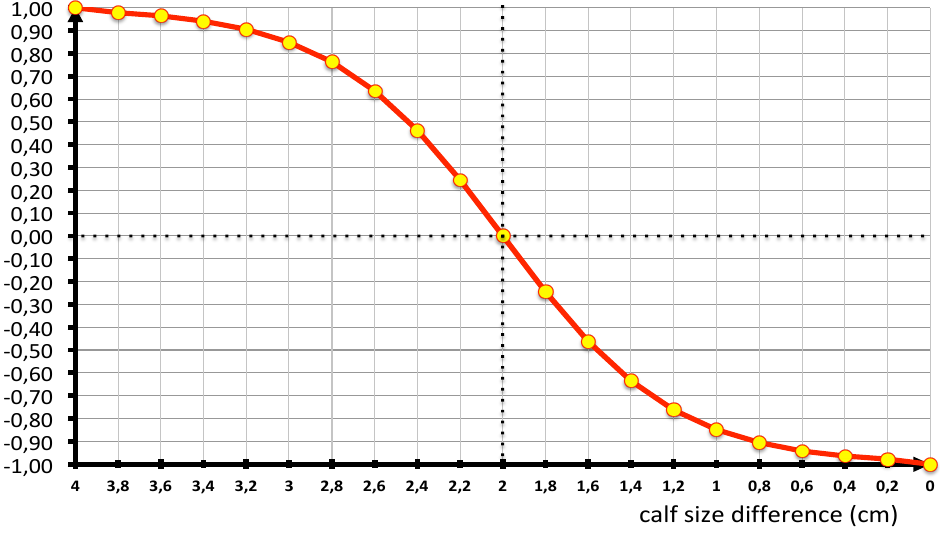
Figure 21. Fuzzy characteristic function µ ∆ Cal fSize ( H ( x , t ) risk of PE. Dynamic Attributes - Heart